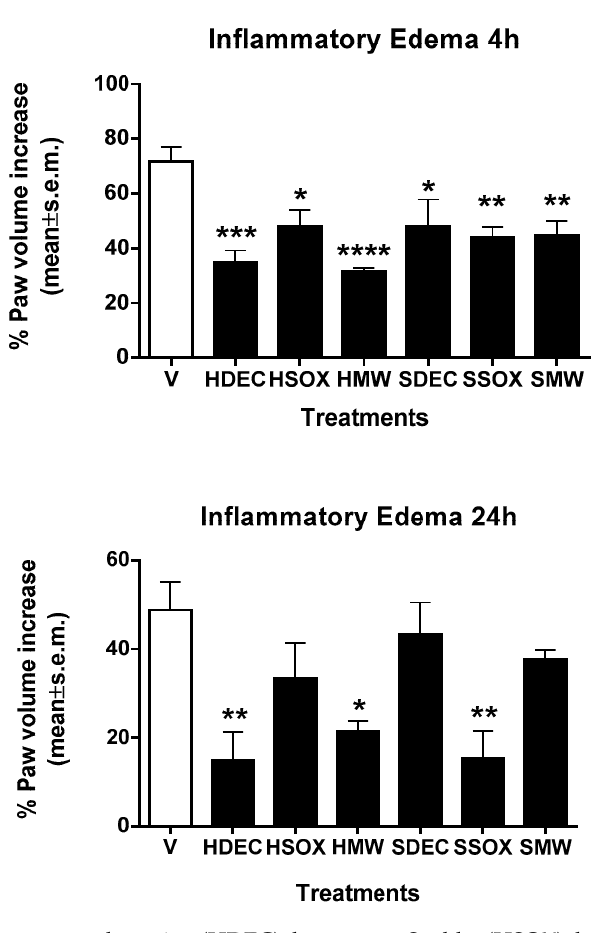
Figure 6. Effect of hot pepper decoction (HDEC), hot pepper Soxhlet (HSOX), hot pepper microwave (HMW), sweet pepper decoction (SDEC), sweet pepper Soxhlet (SSOX) and sweet pepper microwave (SMW) on paw edema formation in mice. Extracts were administered in the mice paw 30 min before zymosan at a dose of 100 μ g/paw. * p < 0.05, ** p < 0.01, *** p < 0.001 and **** p < 0.0001 vs. V (vehicle-treated animals). n = 7.